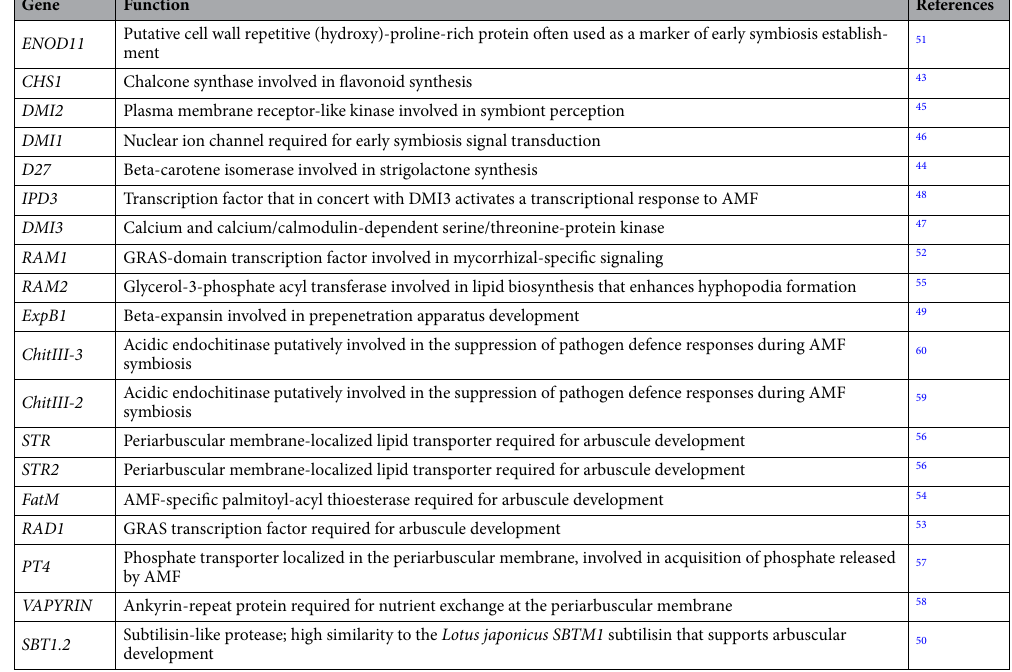
Table 1. List of M. truncatula genes analyzed in this study and their functions in plant–arbuscular mycorrhizal fungus symbiosis.